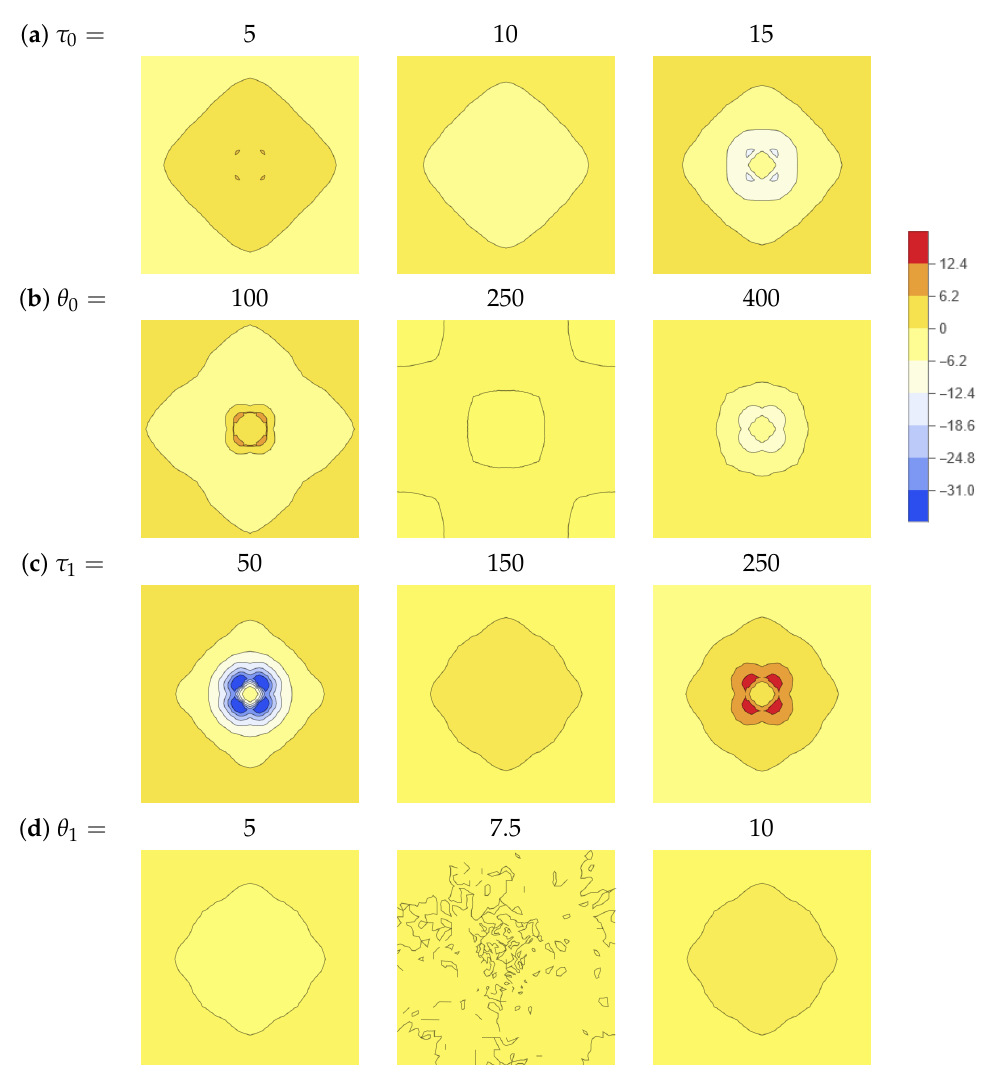
Figure 10. Sensitivity of surface topographies to ( a ) τ 0 , ( b ) θ 0 , ( c ) τ 1 , and ( d ) θ 1 (other parameters were kept fixed). A difference with respect to the reference simulation is shown. Size of the map is 2.4 µ m × 2.4 µ m. The legend presents the colors related to a difference value in µ